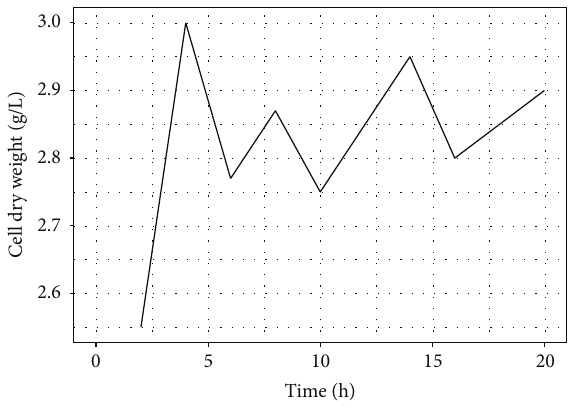
Figure 3: Cell dry weight of L. rhamnosus ATCC 10863 at batch fer- mentation process.